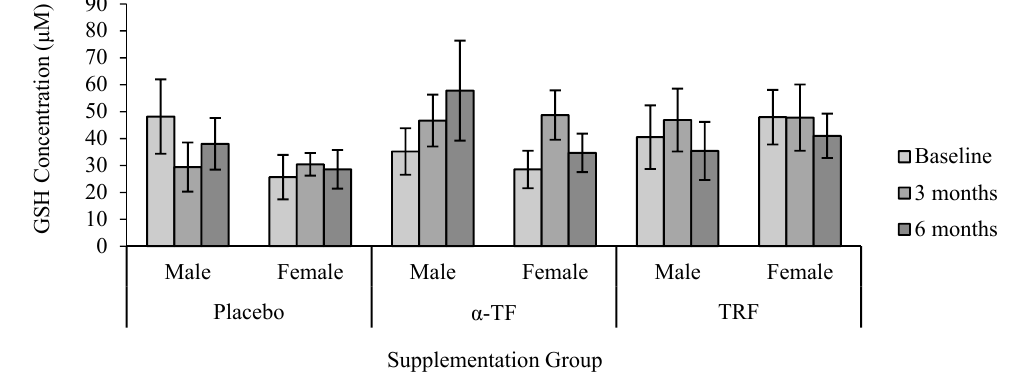
Figure 8. Effect of α -TF and TRF supplementation between males and females on GSH concentration for 6 months. No differences in the level of GSH were found between genders in all supplemented groups.